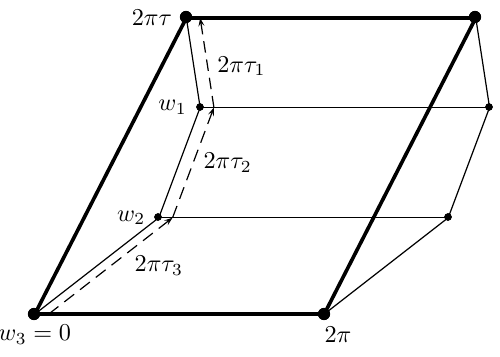
Figure 4. N -cylinder decomposition of necklace channel for N = 3